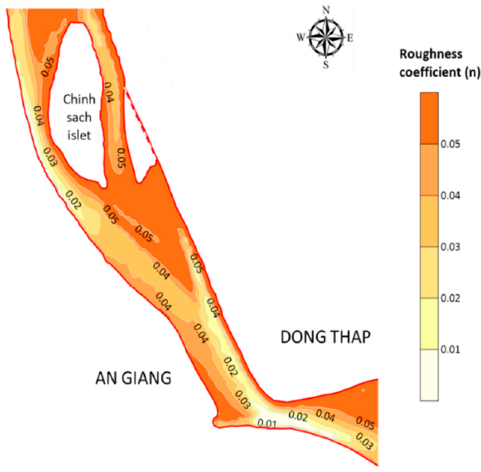
Figure 6. Roughness coefficient for the study area.